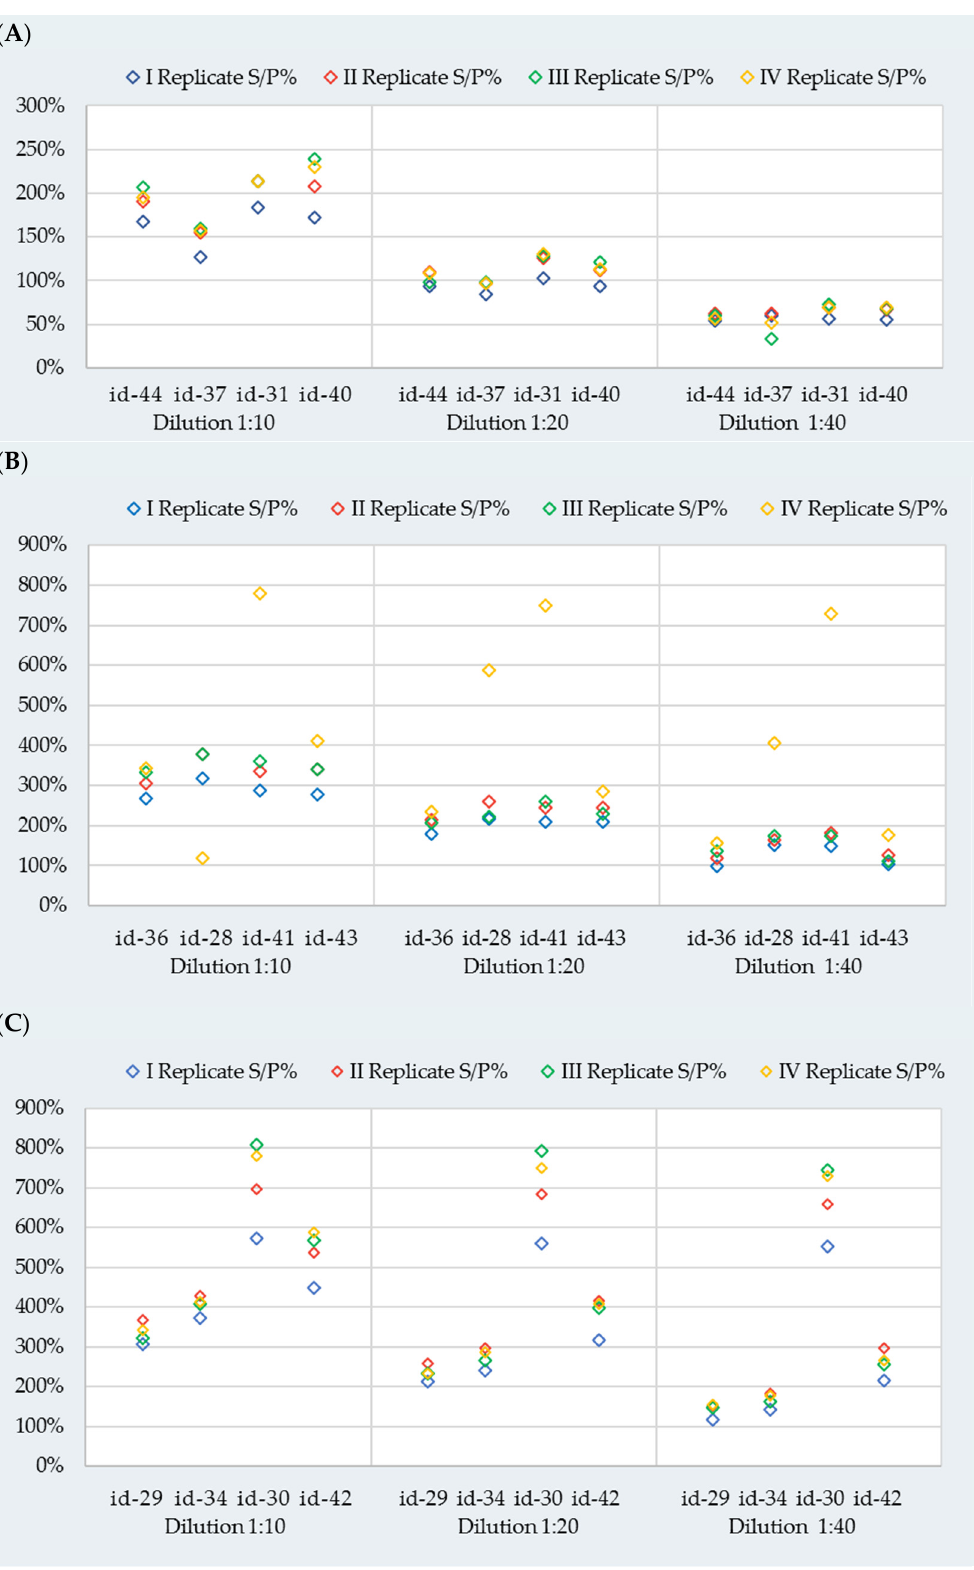
Figure 1. Results obtained from gE indirect ELISA expressed as S/P (positive-to-control ratio); ( A ) Weak reactivity positive samples, diluted at 1:10, 1:20, and 1:40, assayed in four replicates; ( B ) Medium reactivity positive samples, diluted at 1:10, 1:20, and 1:40, assayed in four replicates; ( C ) Strong reactivity positive samples, diluted at 1:10, 1:20, and 1:40, assayed in four replicates.